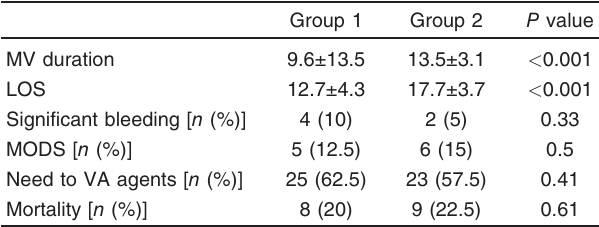
Table 3 Comparison between the two groups regarding different outcome